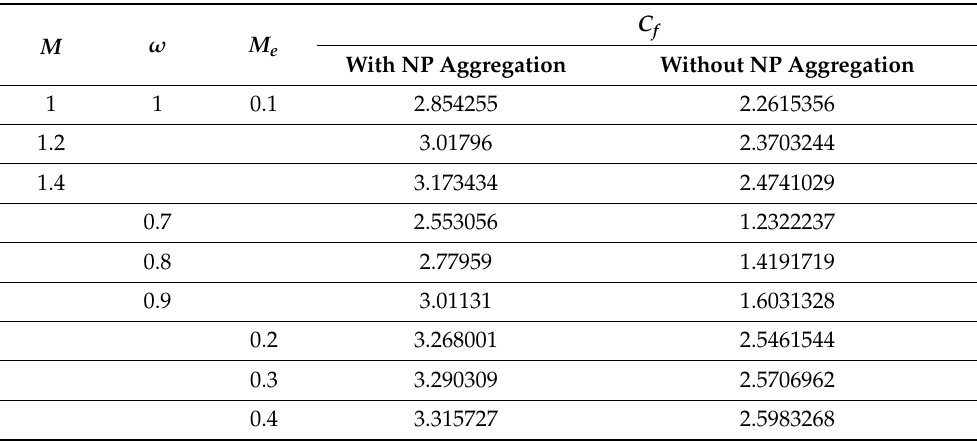
Table 3. Numerical values of the C f for varied ω , M e and M .